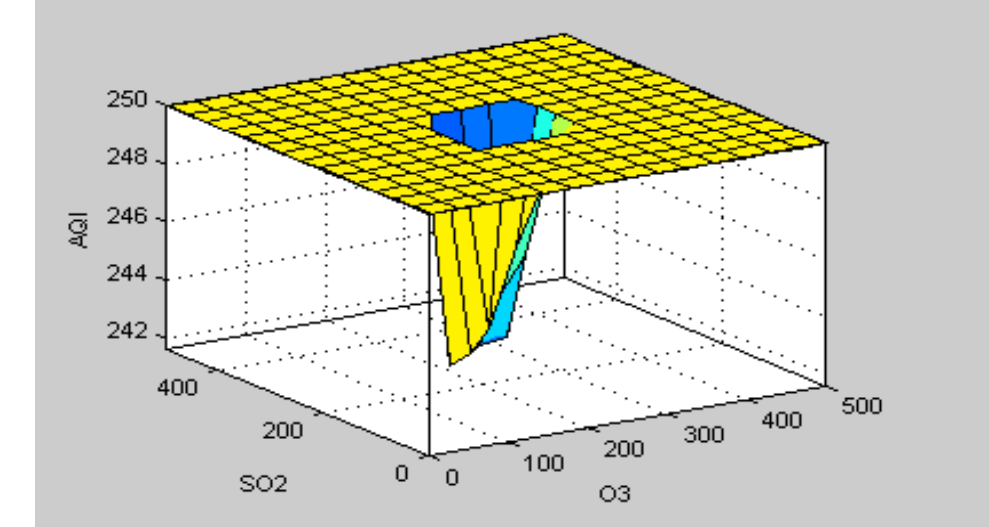
Fig. 9. The relationship between O3 and